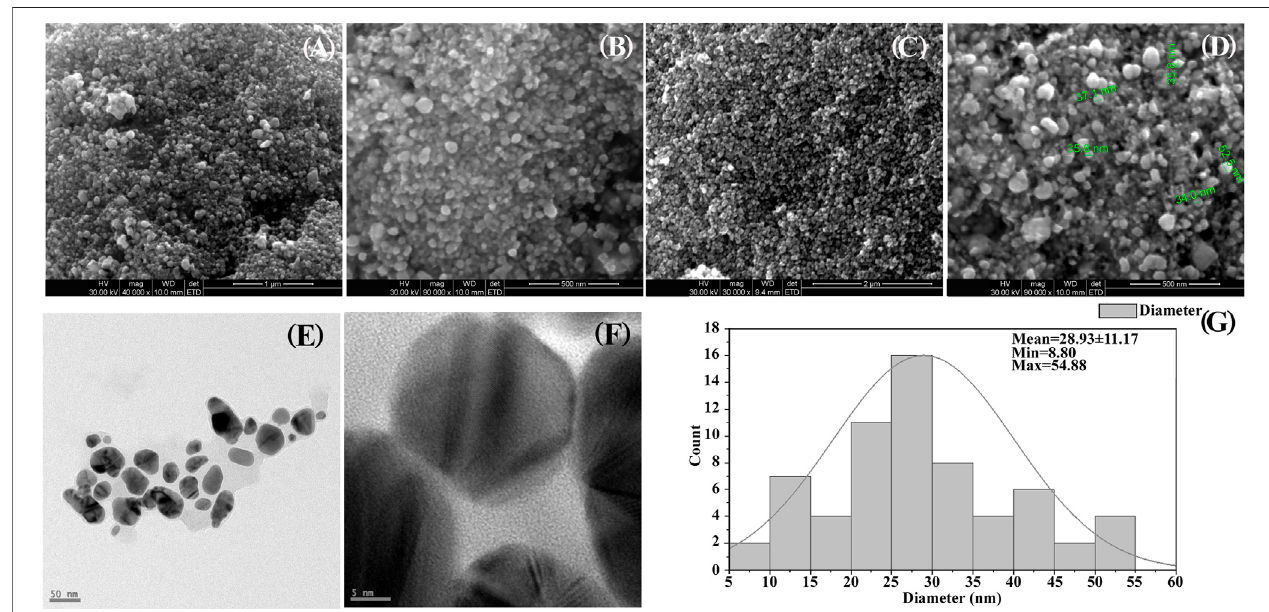
FIGURE3|(A – D) SEMimages showingshape andsize ofpreparedsilvernanocomposite. (A) 1 µM (B, D) 500 nm, (C) 2 µM. (E,F) TEMimages (E) at50 nm and (F) at 5nm, (G) Histogram particle size distribution of TEM.